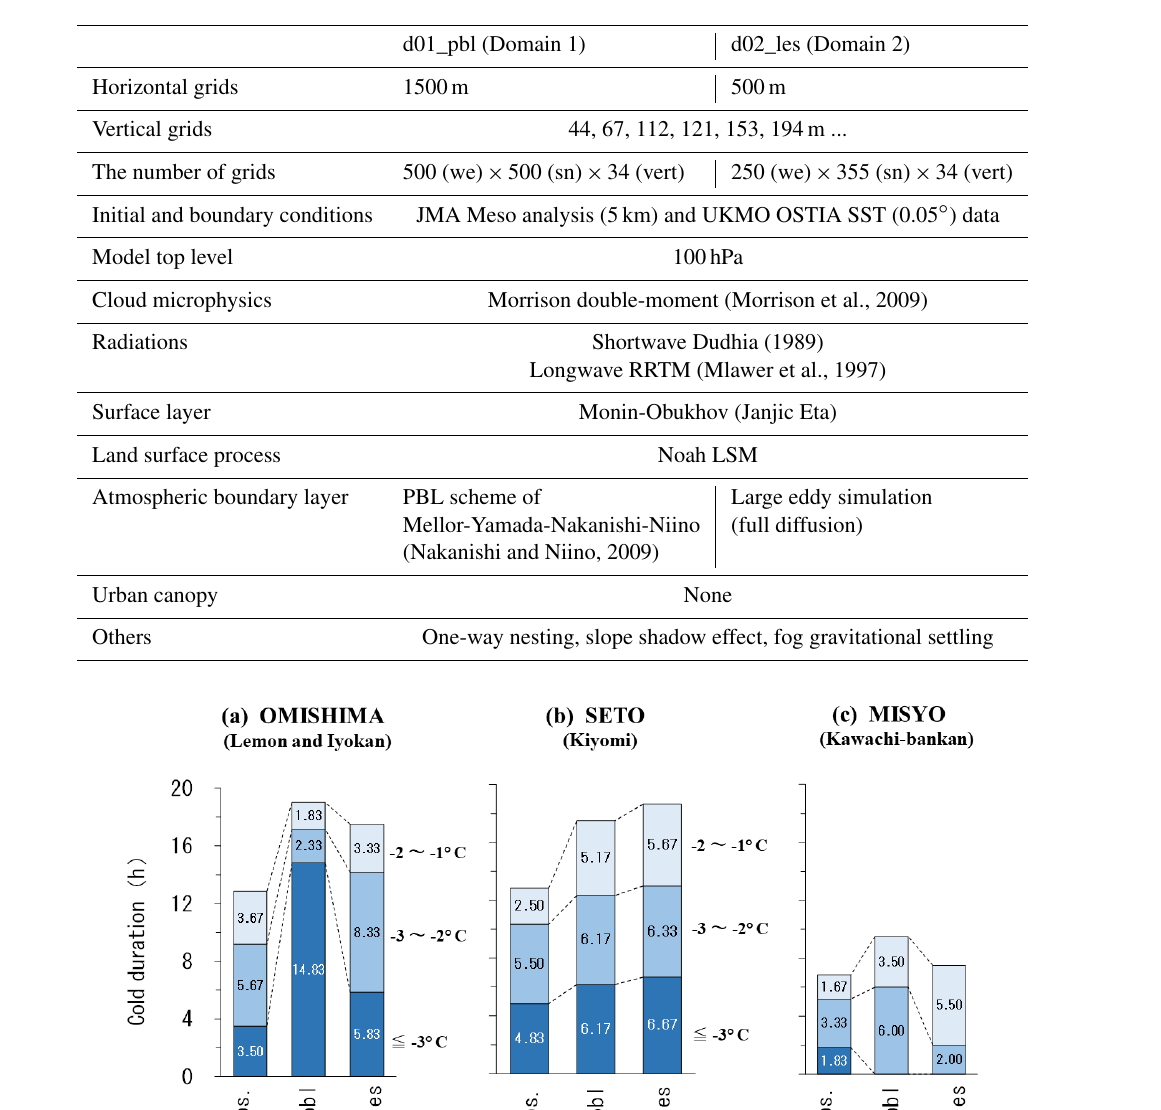
Seto (Fig. 3b) altitudes of observational site, d01 grid, and d02 grid are 140, 121, and 145 m a.s.l., respectively. Misyo (Fig. 3c) altitudes of observational site, d01 grid, and d02 grid are 17, 27, and 12 m a.s.l., respectively. The surface air temperature in the model is a value obtained at a height of 2 m above ground level (a.g.l.), which is diagnostically esti- mated from the Bulk parameterisation for surface heat flux. 1.5 m